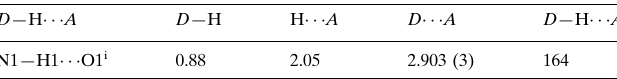
Hydrogen-bond geometry (A˚ , (cid:1)